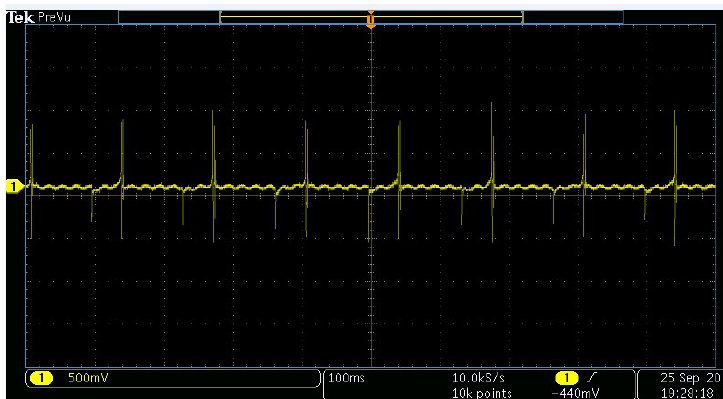
Figure 4. Piezoelectric analysis of the PVDF nanofiber membrane at a cyclic applied force of 5 N and at a rate of 5 Hz. The shown y-axis presents electric voltage (in volts) and the x-axis is the time (in seconds).